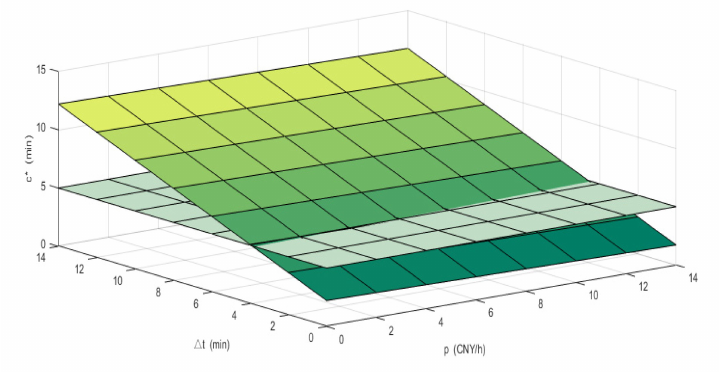
Figure 1. Correlation of ∆ t , p and c ∗ in the Red Flag Street